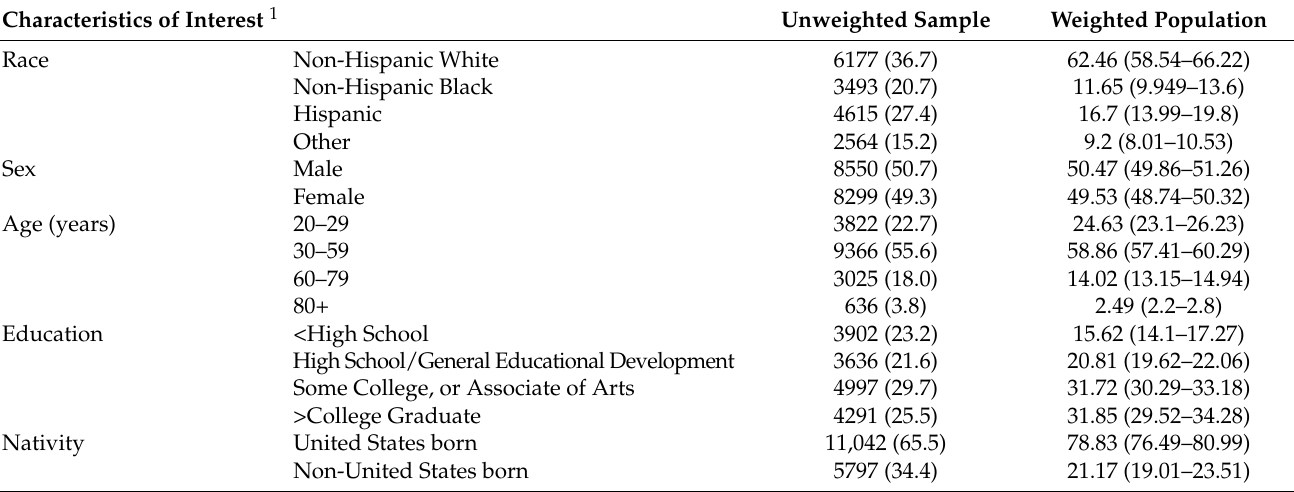
Table 1. Sociodemographic and clinical characteristics of the NHANES sample: